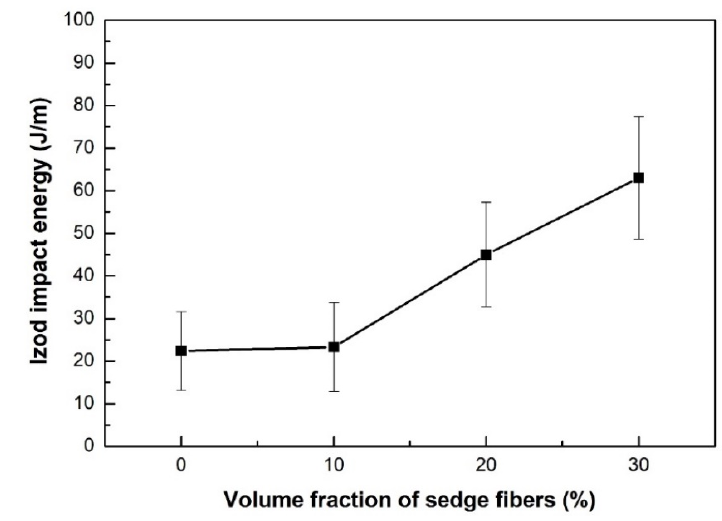
Figure 4. Izod impact energy as a function of the fiber fraction for the neat epoxy resin and CM fiber-reinforced composites.